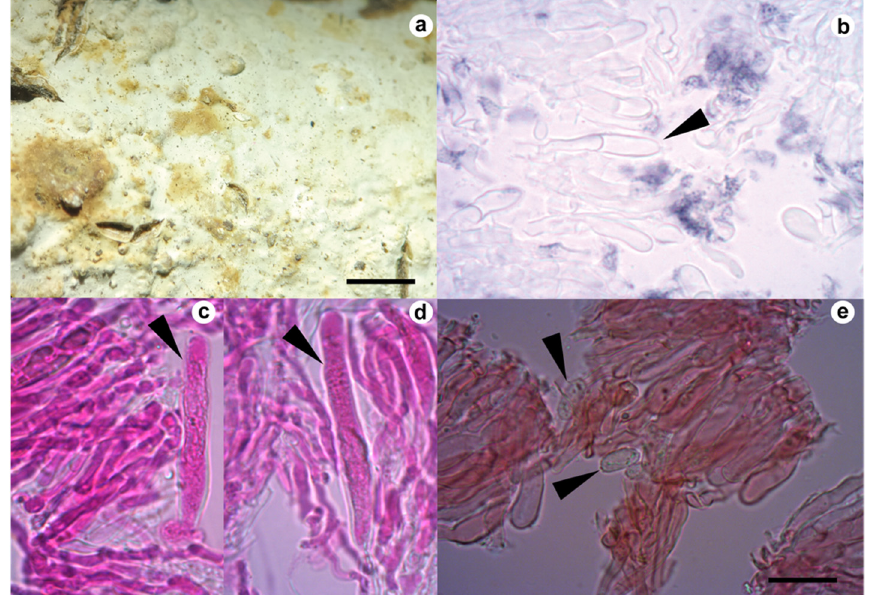
Figure 2. Gloeocystidiellum lojanense : ( a ). basidiome; ( b ). gloecystidias (black arrowhead) in Meltzer's reagent; ( c , d ). gloecystidias (black arrowheads) with granular protoplasmic content in Phloxine; ( e ). basidiospores in Congo Red. Scale bar = 10 µm except (a) 1 cm.